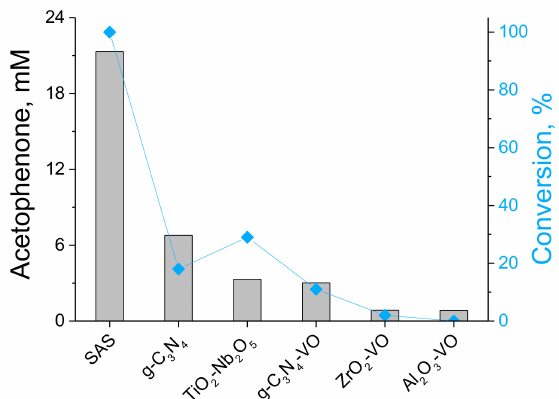
Figure 1. Alcohol oxidation using various photocatalysts. Reaction conditions: 1 mL MilliQ water with [ 5a ] = 25 mM, [sodium anthraquinone-2-sulfonate (SAS)] = 0.75 mM, or [heterogeneous photocatalyst] = 10 mg/mL. Reactions were performed for 24 h at 30 ◦ C under atmospheric conditions and irradiated under visible light ( λ > 400 nm). These experiments have been performed as single